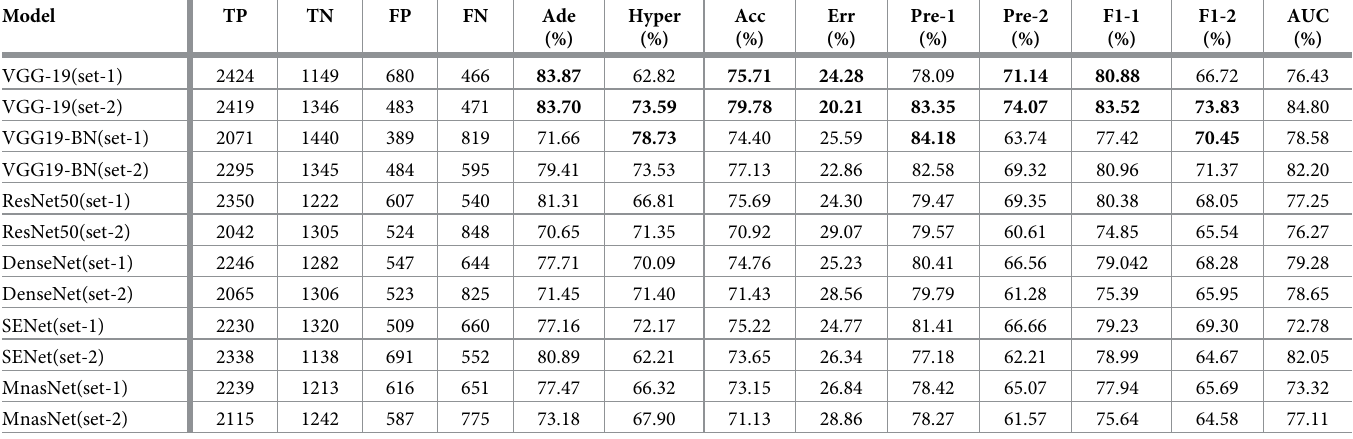
Table 3. Evaluation